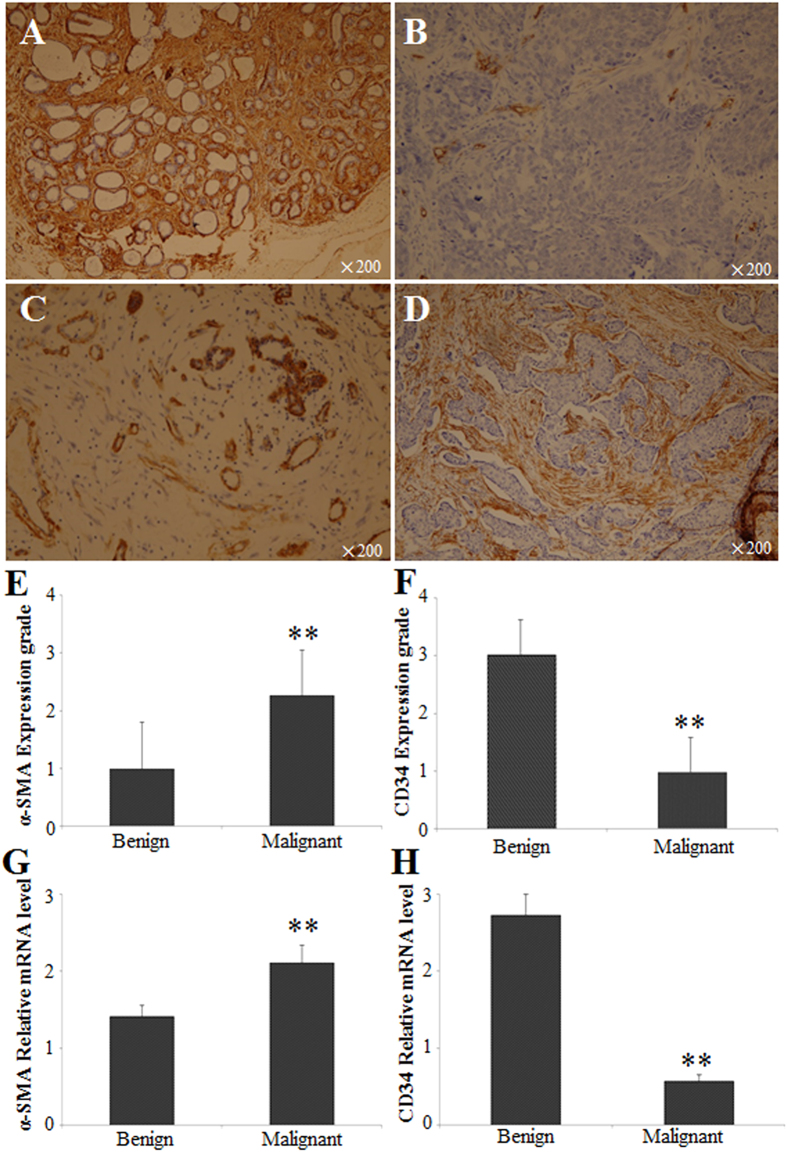
Expressions of α-SMA and CD34 in patients with benign and malignant breast lesions(A) The expression of CD34 in benign breast lesions stromal cells shows strong positive signal. (B) The expression of CD34 in breast cancer stromal cells shows negative signal. It is expressed in blood vessel. (C) The expression of α-SMA in benign breast lesions stromal cells shows negative signal. It is expressed in ductal myoepithelial cells. (D) The expression of α-SMA in breast cancer stromal cells shows strong positive signal. Magnification: 200×, staining method: PV9000. Compared with the benign lesions, **P < 0.01.